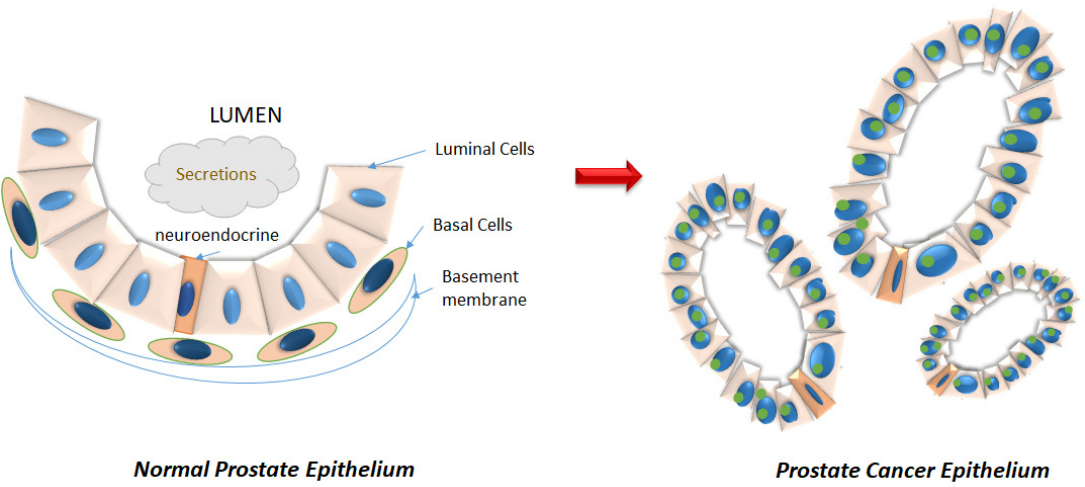
Figure 1. Disruption of the prostatic epithelium during neoplastic progression. ( Left ) The normal prostatic acinus consists of an epithelial compartment consisting of basal (orange) and luminal (pink) cells, as well as a minor population of neuroendocrine cells (darker orange) that serve as stem cells in case of damage repair. The basal cells line the basement membrane. ( Right ) Cancer is characterized by luminal hyperproliferation resulting in the formation of multiple new glands, loss of basal cells, breakdown of basement membrane, prominent nucleoli (green), and nuclear enlargement.